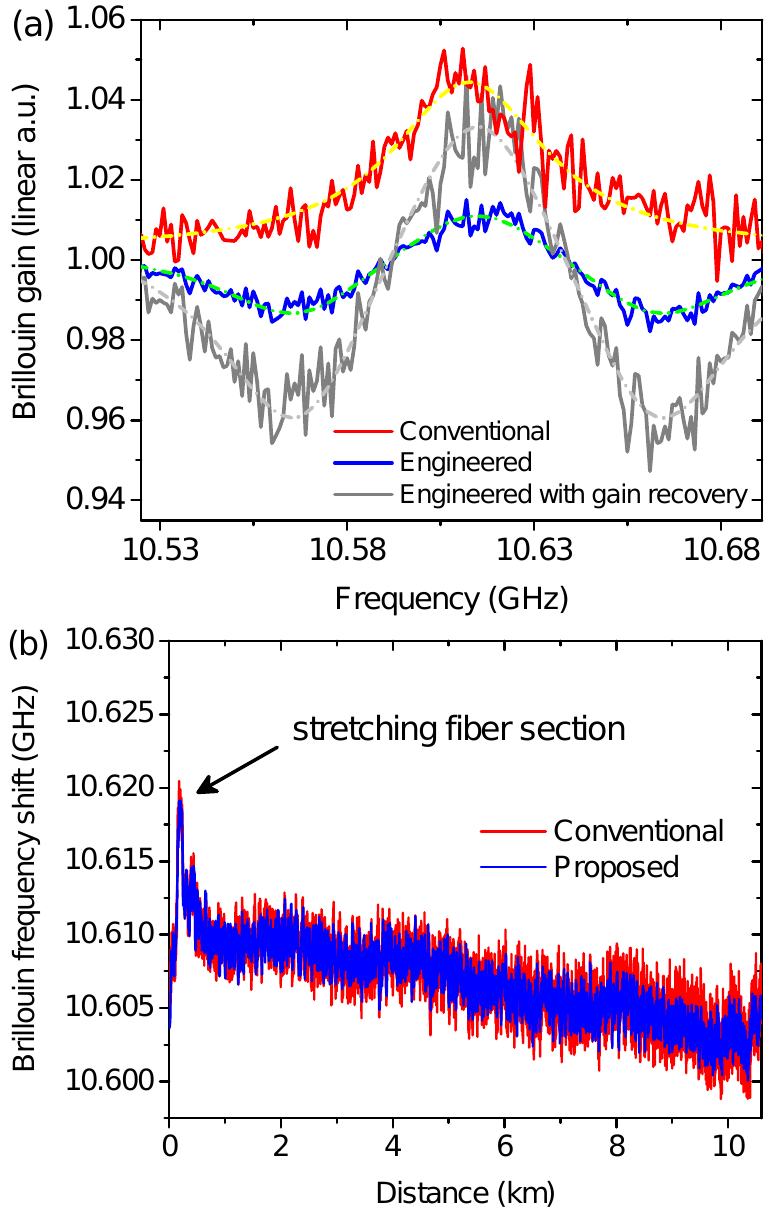
Figure 5. Experimental results of: ( a ) the reconstructed conventional (red) and engineered BGS with (gray) and without (blue) gain recovery; ( b ) the estimated BFS distribution with a stretching section. The estimated BFS from the Voigt function fitting is depicted in Figure 5b. It is clearly indicated that, the BFS distributions from both spectra are well overlapped and the one from the engineered BGS shows an even clearer trace, indicating a better functionality in accurate BFS estimation. In order to verify this, 48 measurements have been carried out consecutively. The BFS error distribution is calculated by the root-mean-square (RMS) value of the acquired 48 BFS values from the fitting curves at the same fiber section. As depicted in Figure 6, the frequency error from the engineered BGS is only 45.7% of that from the conventional BGS (quantified according to the dash dotted curves at the end of the fiber), showing very good agreement with the simulated predictions. Thus, under the same frequency error tolerance, the sensing range of the BOTDA system can be drastically extended by SBS spectrum